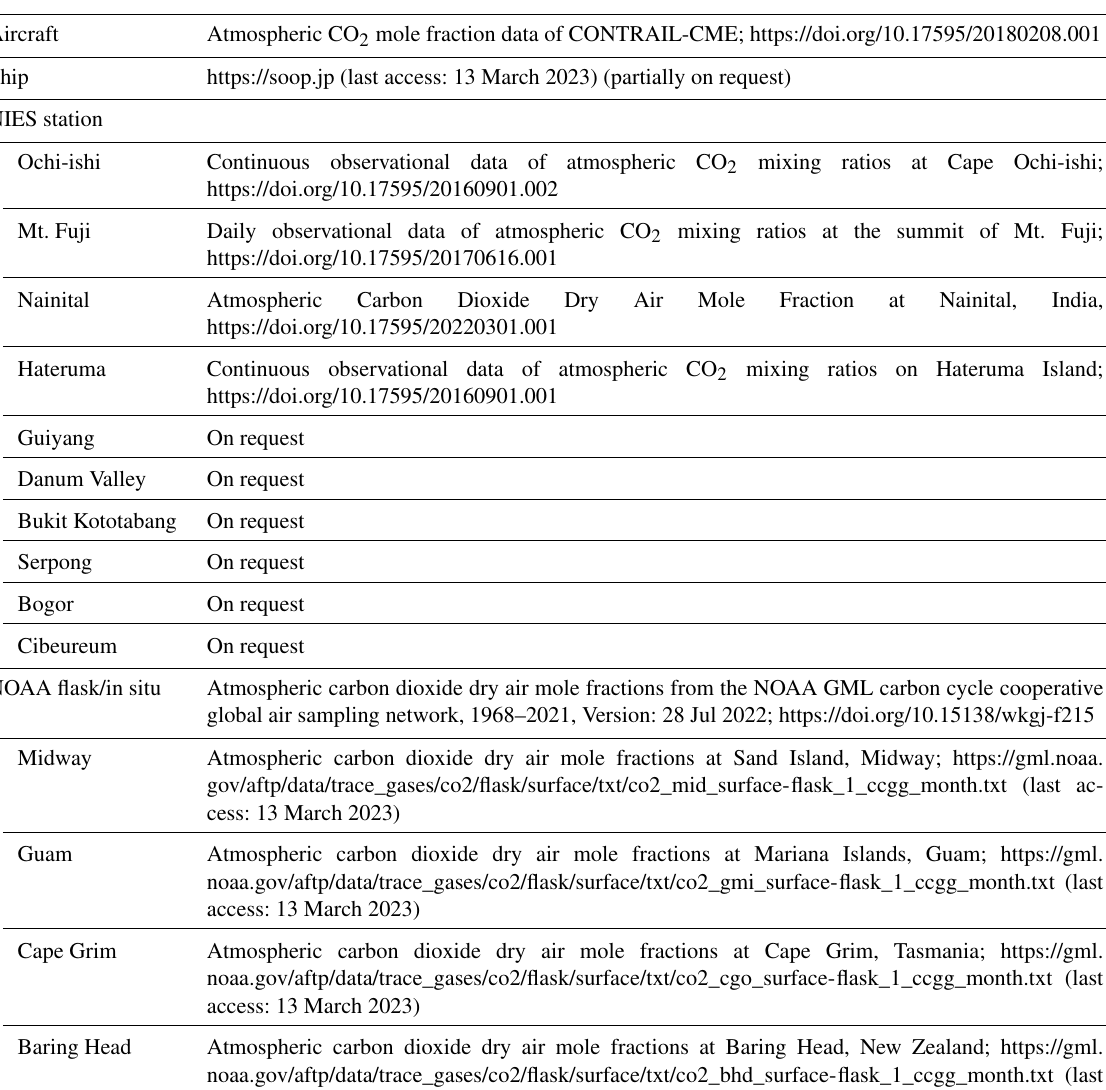
Table B2. In situ measurement data availability.